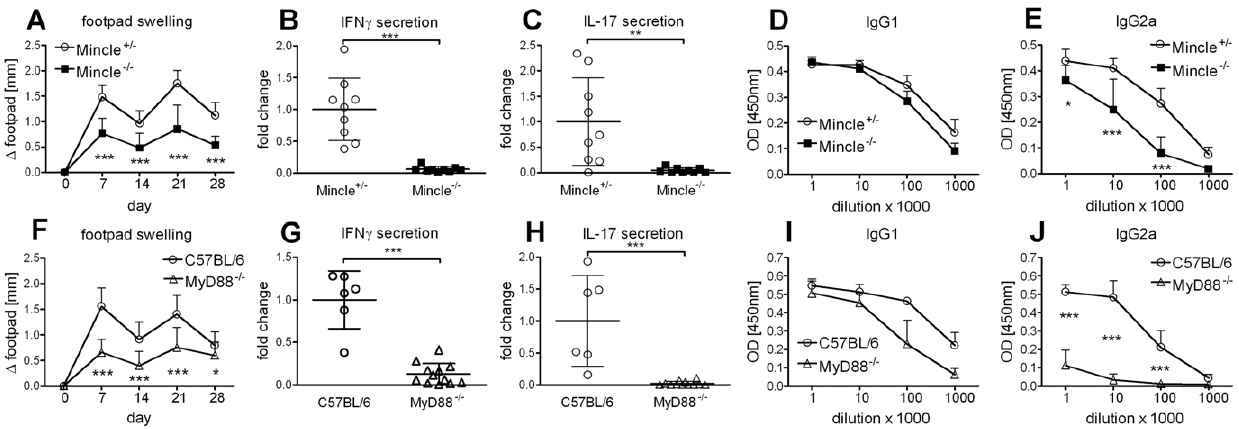
Figure 1. Mincle and MyD88 are required for DDA/TDB adjuvanticity. Footpad swelling ( A ), IFN c , IL-17 ( B, C ) secretion and H1-specific antibodies ( D, E ) in Mincle 2 / 2 and littermate controls. Data presented as mean 6 SD pooled from 2 independent experiments with 4-5 mice/group. Footpad swelling ( F ), IFN c , IL-17 ( G, H ) secretion and H1-specific antibodies ( I, J ) in MyD88 2 / 2 and C57BL/6 controls. Data presented as mean 6 SD pooled from 3 independent experiments with 2-5 mice/group. Cytokine production of cells isolated from the draining lymph nodes.